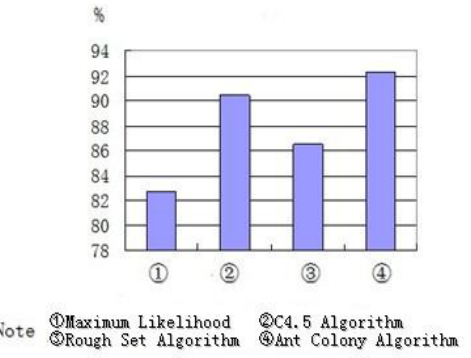
Figure7. Comparisons of total accuracy assessment based four classification methods